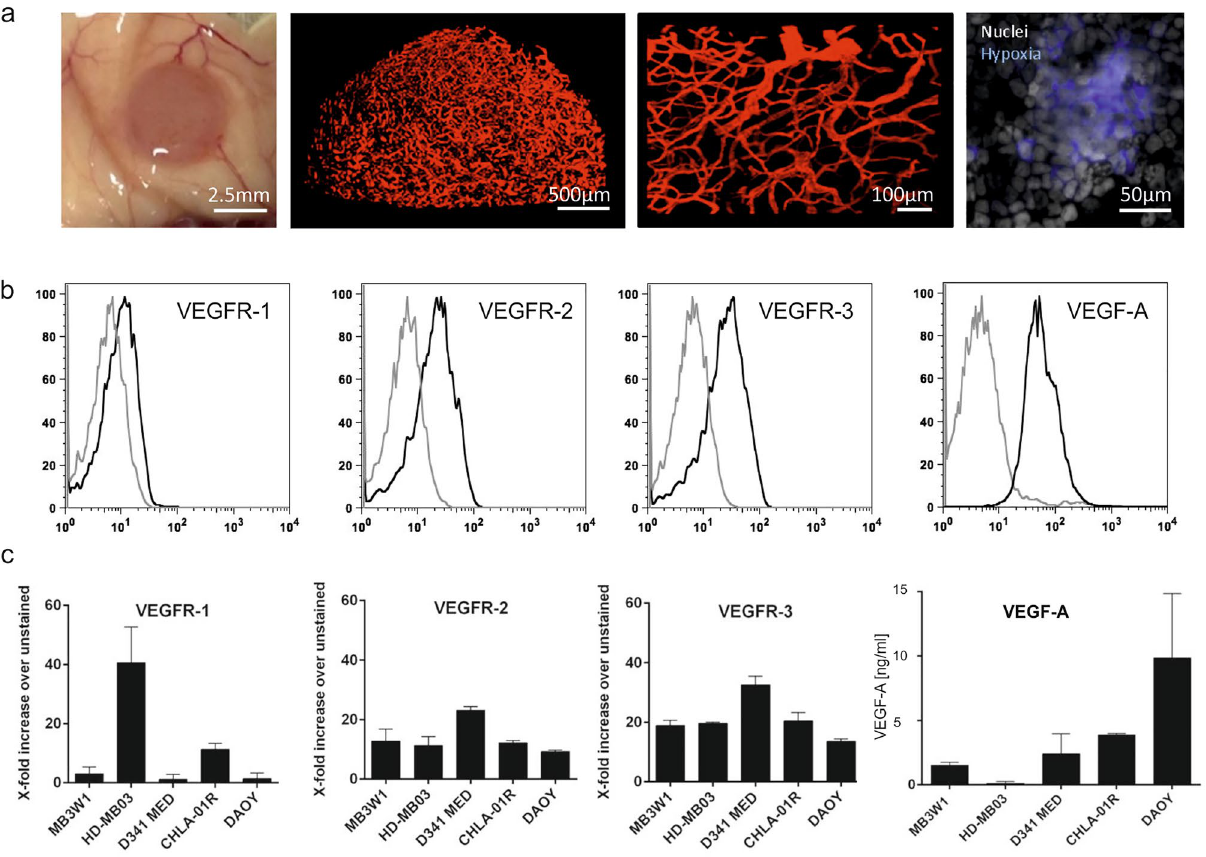
Figure 1. MB3W1 medulloblastoma cells express VEGF-receptors and produce VEGF-A. ( a ) Left: Neo- vascularization of the subcutaneous tumor in NOD/SCID mice. Center left and right: 3D reconstruction of tumor vasculature (VE-Cadherin-AlexaFluor647 staining) with LSFM. Right: MB3W1 are highly hypoxic in the center of spheres as visualized by pimonidazole incubation, which stabilizes thiol-groups in proteins, peptides and aminoacids in hypoxic cells. ( b ) MB3W1 characterization for VEGFR-1, VEGFR-2 and VEGFR-3 expression and VEGF-A production with flow cytometry (black line; grey line: unstained control). ( c ) Expression of VEGFR-1, VEGFR-2 and VEGFR-3 expression of different medulloblastoma cell lines calculated as fold-increase of mean fluorescence intensity (MFI) over the unstained control (mean of 2 experiments). Right panel: VEGF-A concentration as measured with ELISA in supernatants from different medulloblastoma cell